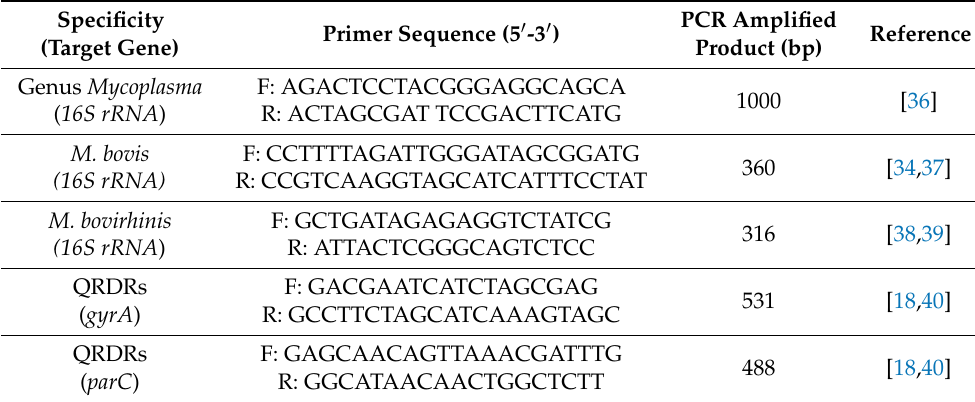
Table 3. Sequence of oligonucleotide primers and amplified PCR products for five target genes of Mycoplasma